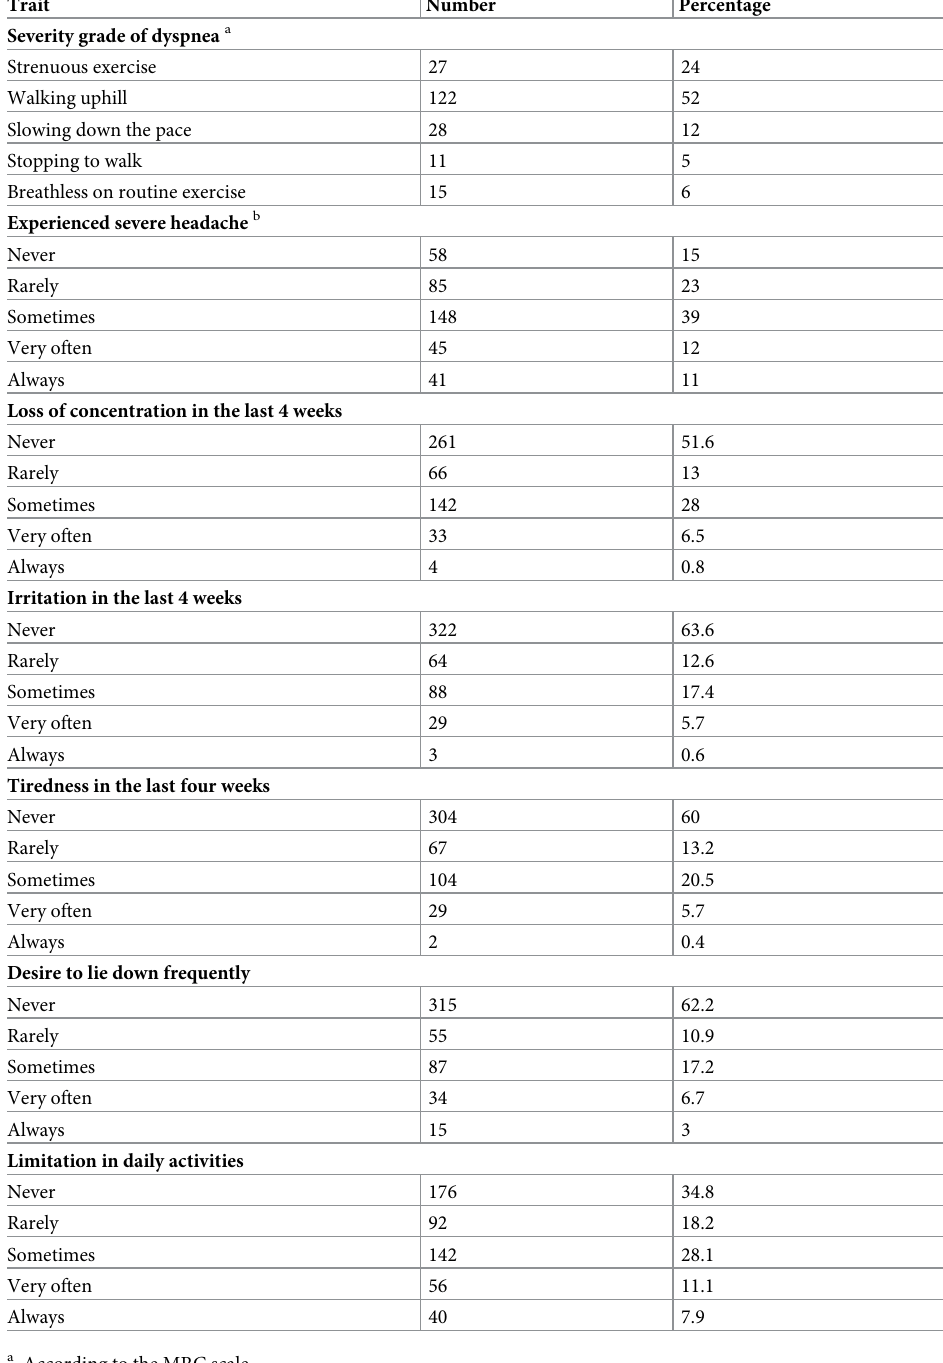
Table 2. Severity (dyspnea and headache) and the functional impact of health hazards on the daily life of the physicians. Trait Number Percentage Severity grade of dyspnea a Strenuous exercise 27 24 Walking uphill 122 52 Slowing down the pace 28 12 Stopping to walk 11 5 Breathless on routine exercise 15 6 Experienced severe headache b 58